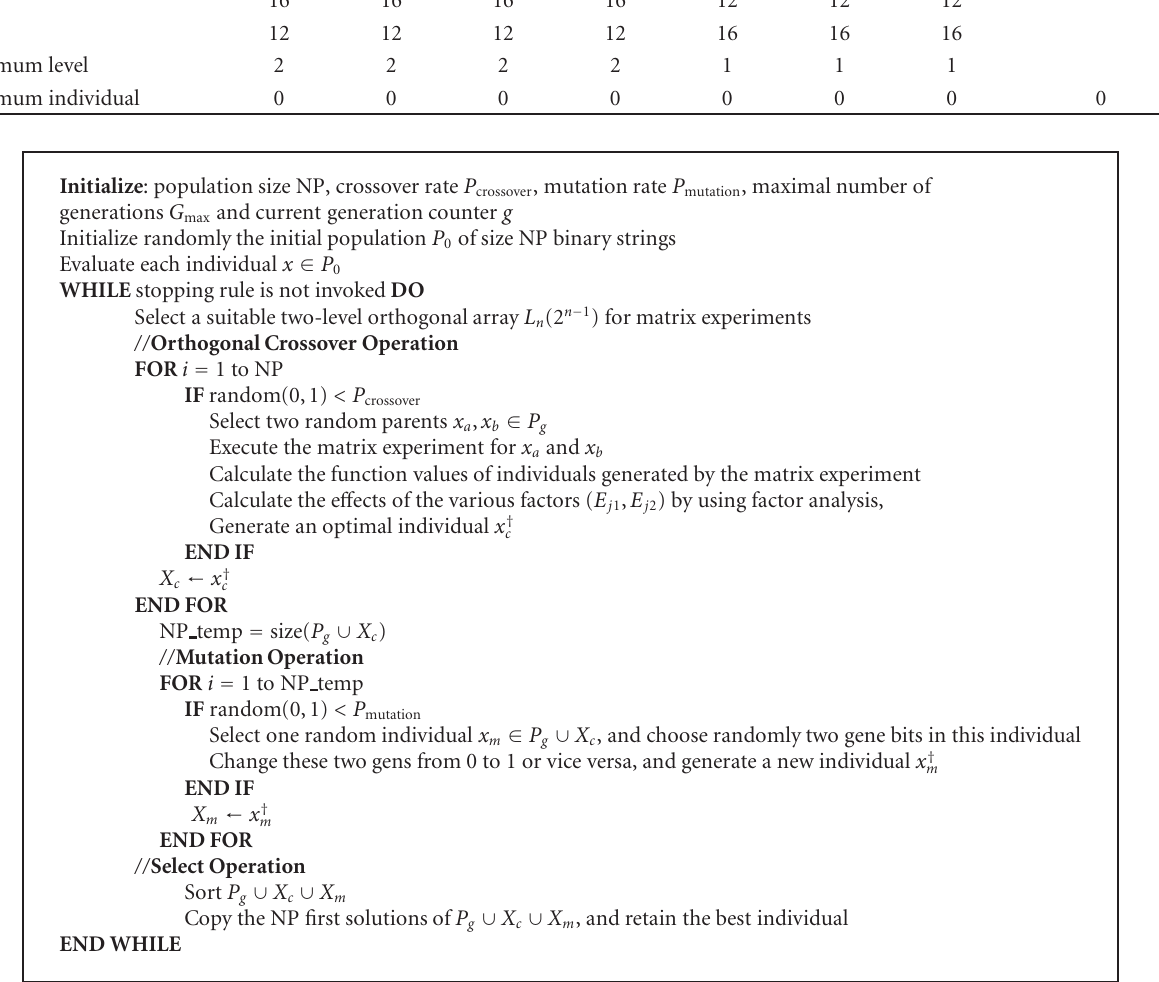
Table 4: Generating a better individual from two individuals by orthogonal experiment design and factor analysis. Combination number ( j )